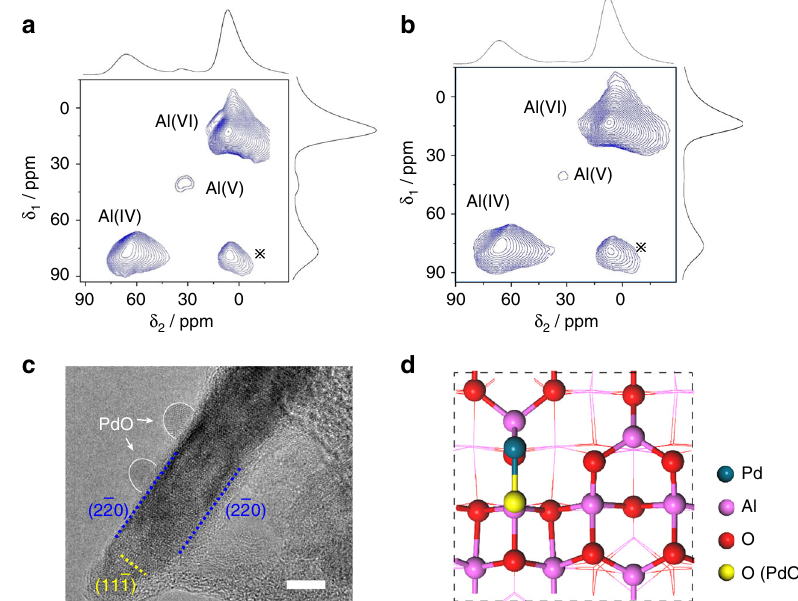
Fig. 4 Structural characterization of NA-Al 2 O 3 and Pd/NA-Al 2 O 3 . a Two-dimensional 27 Al MQ MAS NMR spectra of NA-Al 2 O 3 . b Two-dimensional 27 Al MQ MAS NMR spectra of